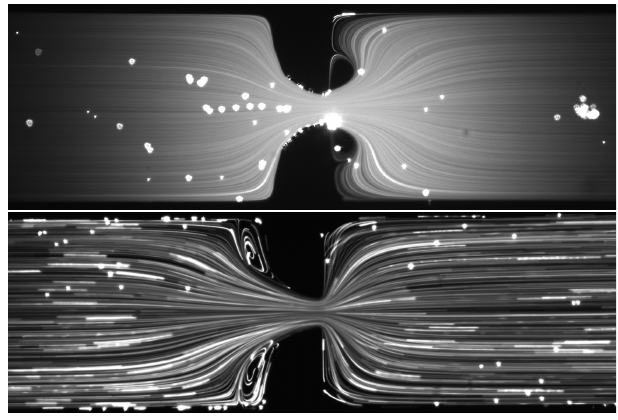
Figure 2. Flow patterns for distilled water ( Re = 49.3) and 400 ppm polyacrylamide (PAA) solution with 1% NaCl ( Re = 0.82). The flow direction is from left to right. Images adapted from Campo-Deaño et al. [54]. Copyright Journal of Non-Newtonian Fluid Mechanics,